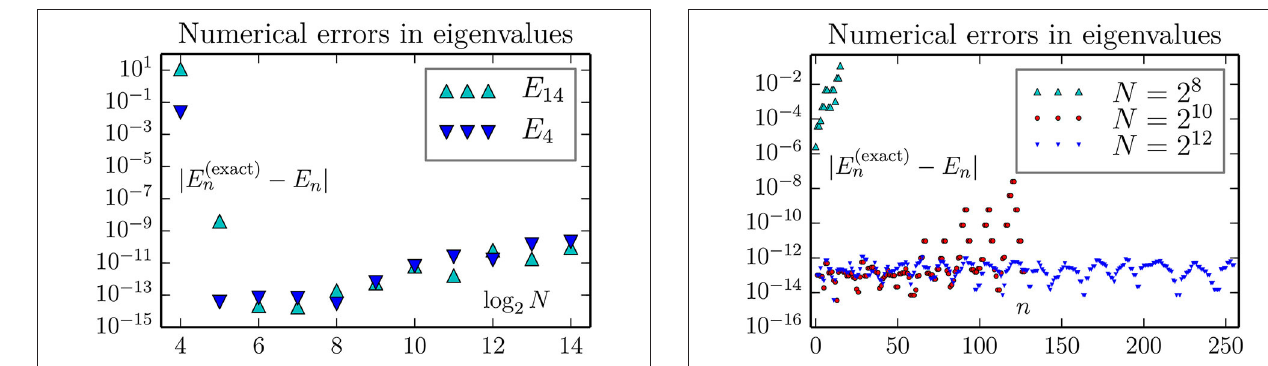
FIGURE 8 | With a FFT representation of the Laplace operator the discretization error drops exceptionally fast with δ x “small enough” the effect of numerical roundoff becomes visible; the latter leads to an increase in error with δ x . The results in this figure is for a one-dimensional lattice, but the behavior is the same in all dimensions. The lesson is that we should make δ x “small enough” (which in general may be difficult to determine a priori ), but not smaller. It may also be possible to rewrite the eigenvalue problem to a form with less amplification of roundoff errors.